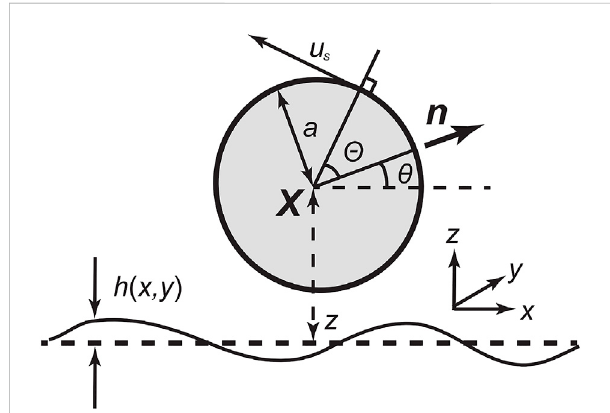
FIGURE 1 Schematic diagram of a spherical tangential squirmer, of radius a = 1, near a no-slip wall. Here, X denotes the centre of the spherical swimmer relative to a laboratory reference frame, with Cartesian coordinates ( x , y , z ) and h ( x , y ) is the height of the surface above its average midplane (dashed) at z = 0. Furthermore, z is overloaded and also represents the height of the swimmer centre above the midplane, with an analogous overloading of x , y . Whether x , y , z refer to coordinatesorthe overloaded de fi nition X = ( x , y , z )for thelocation of the squirmer centre will be clear from context. The unit vector n gives the orientation of the swimmer, which makes an angle θ relative to the mid-plane of the surface topography, and Θ is the local polar angle of a point on the swimmer ’ surface relative to n . The swimmer ’ s motility is driven by an axisymmetric tangential velocity of its surface, of size u s , and in the direction of increasing Θ , as detailed in the main